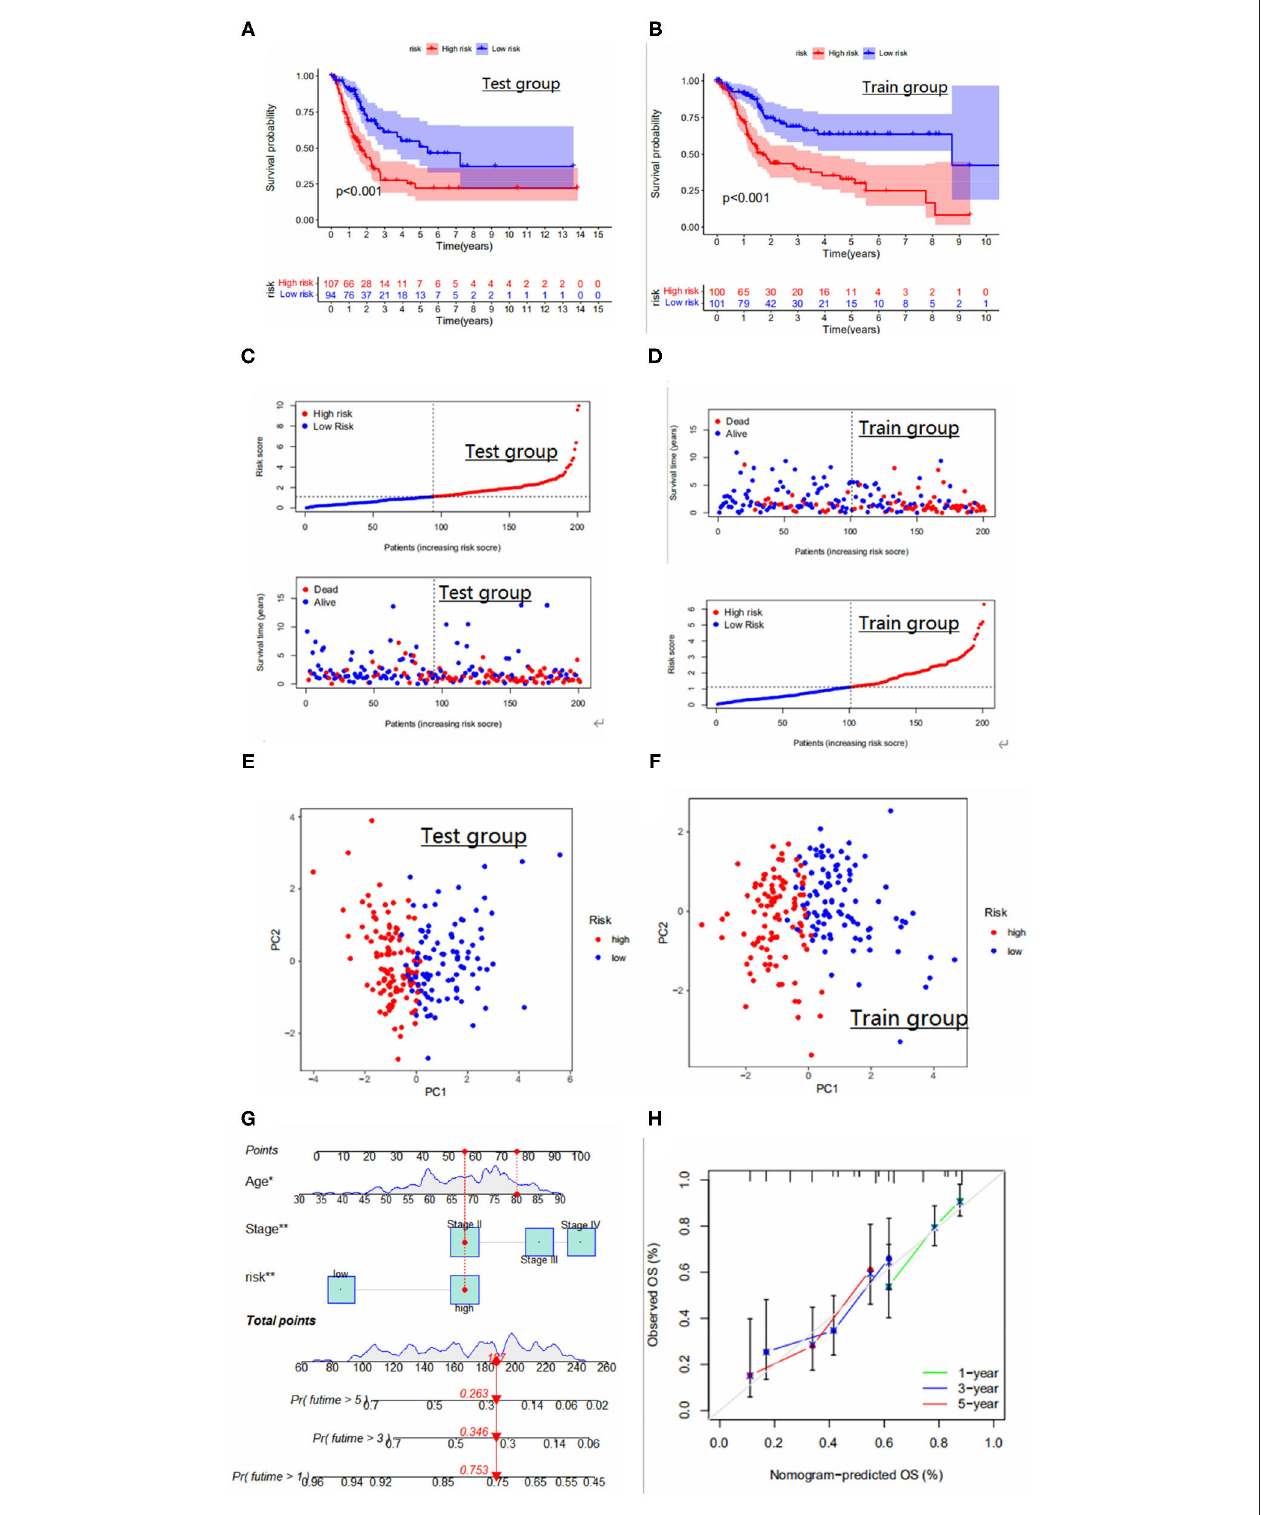
FIGURE 5 | (A,B) Survival curves for high and low risk groups in the Test and Train groups. (C,D) Risk curves for high and low risk groups in the Test and Train groups. Ranked dot and scatter plots showing the risk_score distribution and patient survival status. (E,F) PCA results for the Test and Train groups. PCA analysis based on the prognostic signature. The high and low-risk patients are represented by red and steel blue dots, respectively. (G) Nomogram for predicting 1-year, 3-year, and 5-year survival rates for bladder cancer patients. (H) Calibration curves of nomogram for predicting survival in bladder cancer patients in the test group.